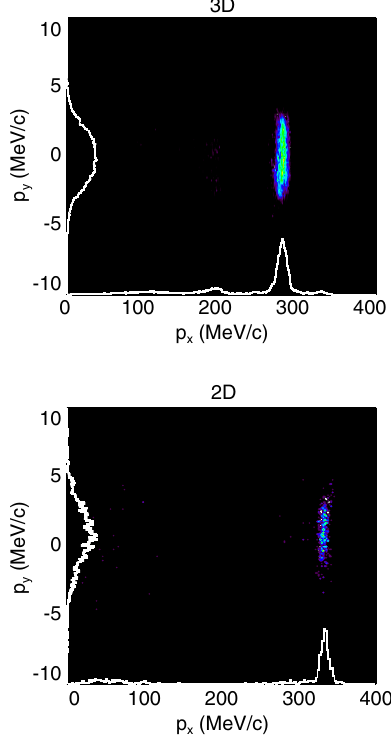
FIG. 1. Longitudinal and transverse momentum of the trapped electron beam at dephasing for 3D and 2D simulations. The plot of the 3D simulation appears more dense because of the higher number of total macroparticles in the simulation, but numbers for energy spread and emittance are similar in both